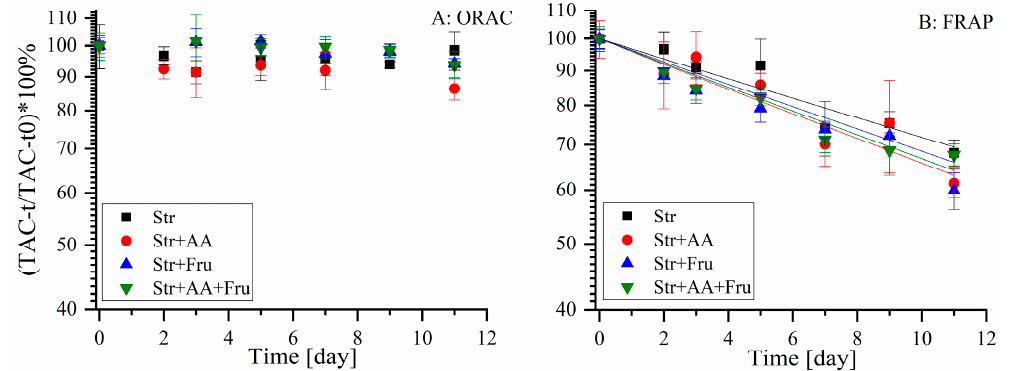
Figure 4. Relative TAC of strawberry polyphenols during shelf-life experiment at 37 °C, in citric buffer pH = 3, 50 mM and different formulations: Str—strawberry, Fru—fructose (10%) and AA—ascorbic acid (0.022%). Measured using ORAC ( A ) and FRAP ( B ) methods. * Error bars represent standard error (n = 2), in ( B ) the line represents a fit to first-order kinetics.